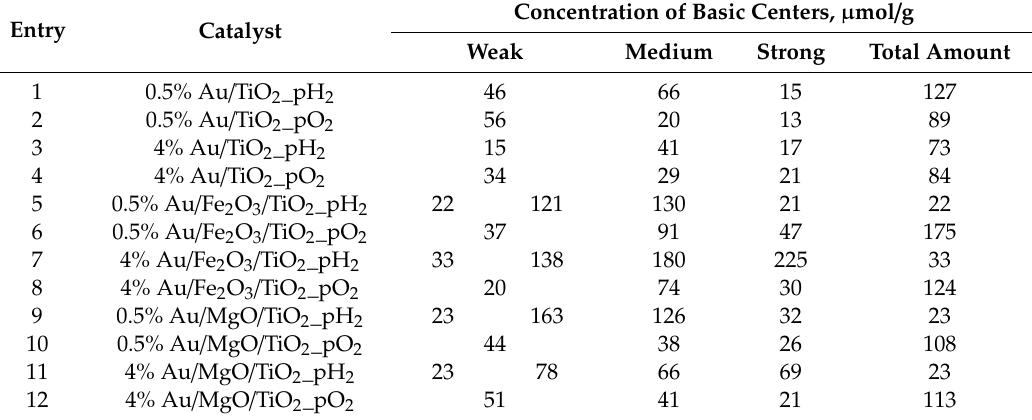
Table 5. Basic properties of